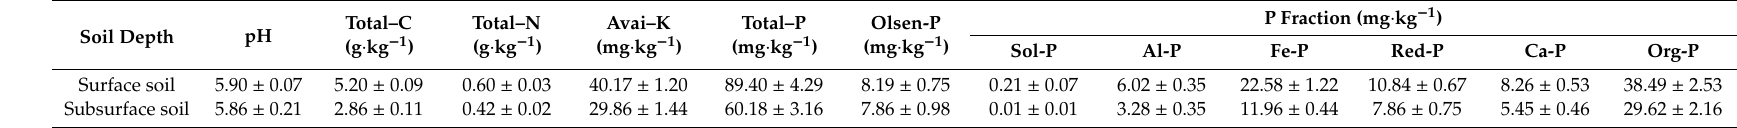
Table 1. Basic soil physicochemical